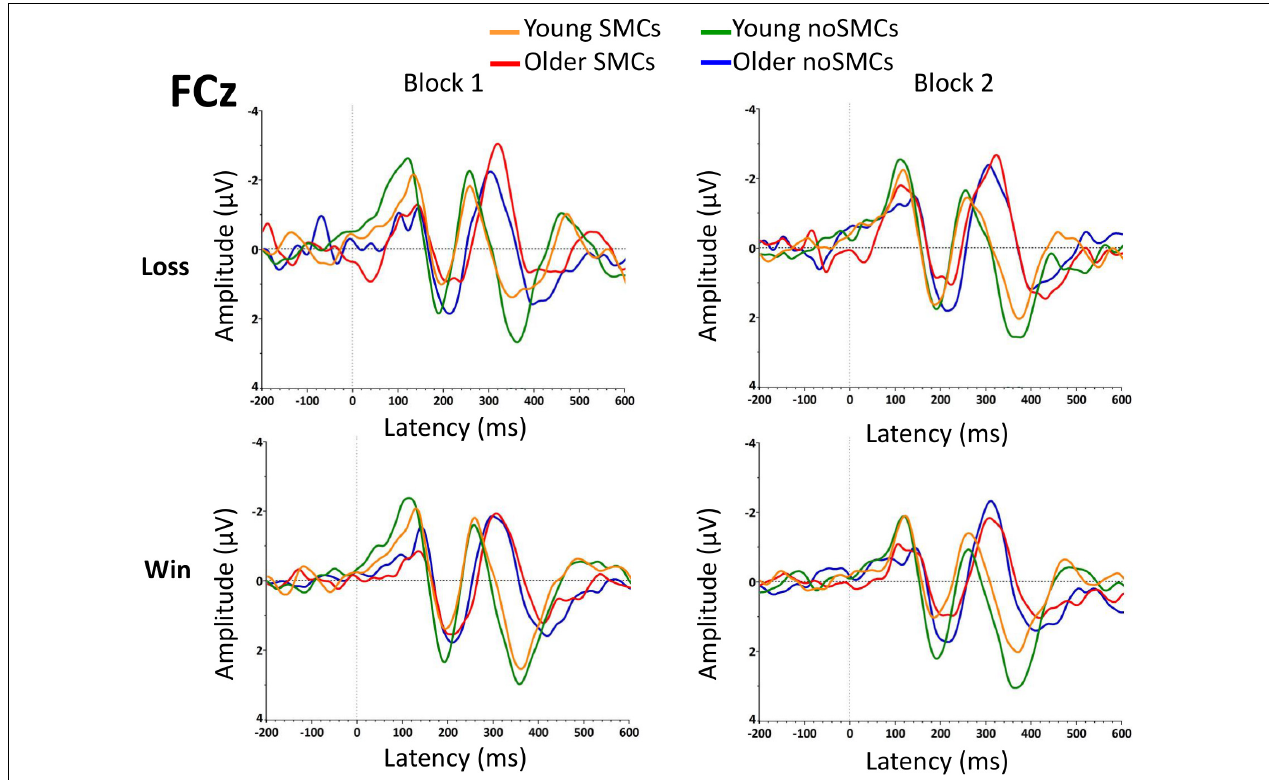
FIGURE 4 | Grand averages of the FRN component at the FCz electrode for the two